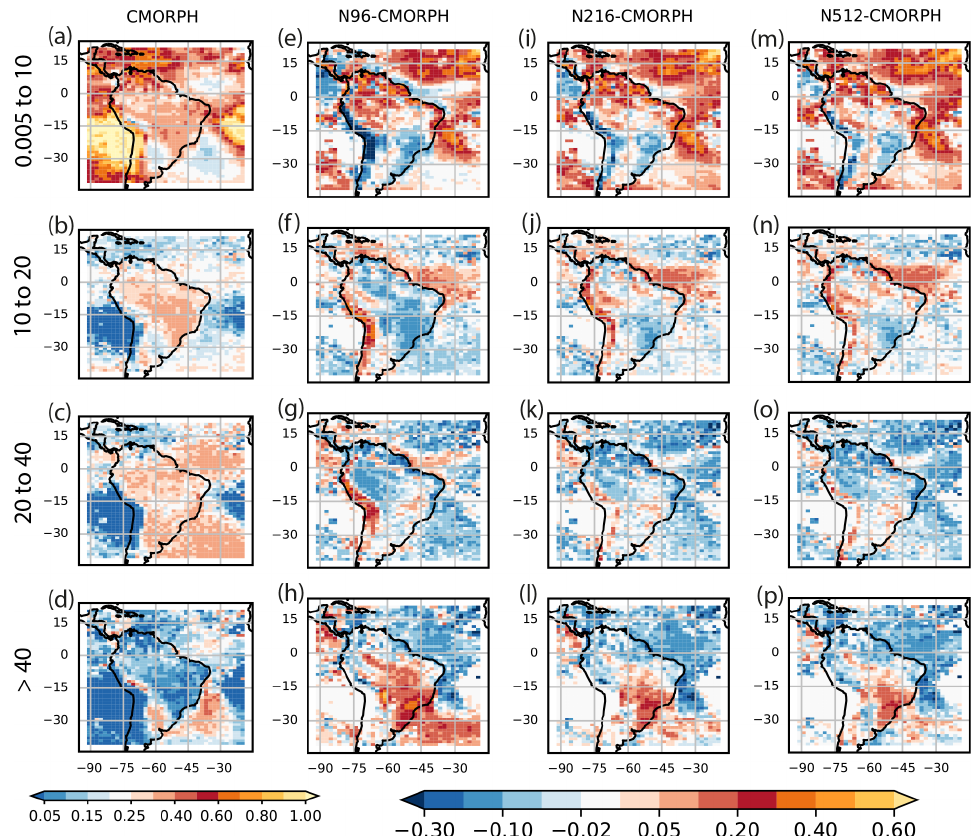
Figure 9. Fractional contribution to the total precipitation from ranges of intensity bins shown in the labels above each panel for CMORPH (a–d) (the sum of each column is unity). Differences in the fractional contributions compared against CMORPH for N96 (e–f) , N216 (i–l) , and N512 (m–p) (all on the N96 common grid). The four ranges of intensity bins are (first row) 0.005 to 10mmd − 1 , (second row) 10 to 20mmd − 1 , (third row) 20 to 40mmd − 1 , and (last row) > 40mmd − 1